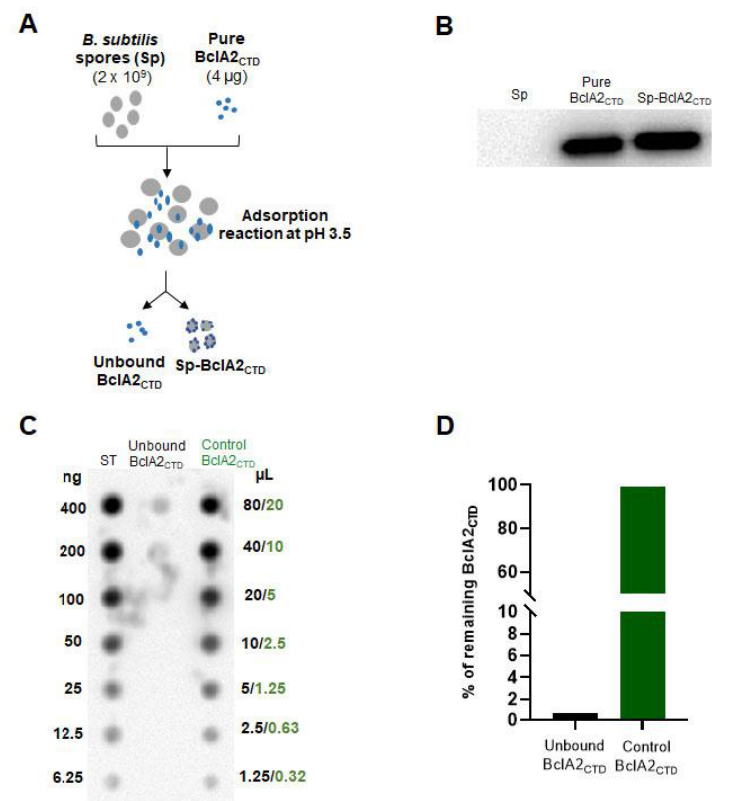
Figure 3. Adsorption of BclA2 CTD on Bacillus subtilis spores. ( A ) Schematic representation of the adsorption reaction. ( B ) Western blotting of spore-extracted proteins after the adsorption reaction with anti-6xHis antibody. B. subtilis spores (Sp) and pure BclA2 CTD were used as negative and positive controls, respectively. ( C ) Dot blot analysis of the supernatant of the adsorption reaction. Loaded volumes (μL) of the supernatant fraction (unbound BclA2 CTD ) and of the pure protein incubated in the same condition of adsorption (control BclA2 CTD ) are indicated in black and green, respectively. Known amounts (ng) of the pure protein incubated at −80 °C (ST) were used as standard. ( D ) Plot of the densitometric analysis of the dot blot experiment of panel C, considering the amount of protein stored at −80 °C as 100%.